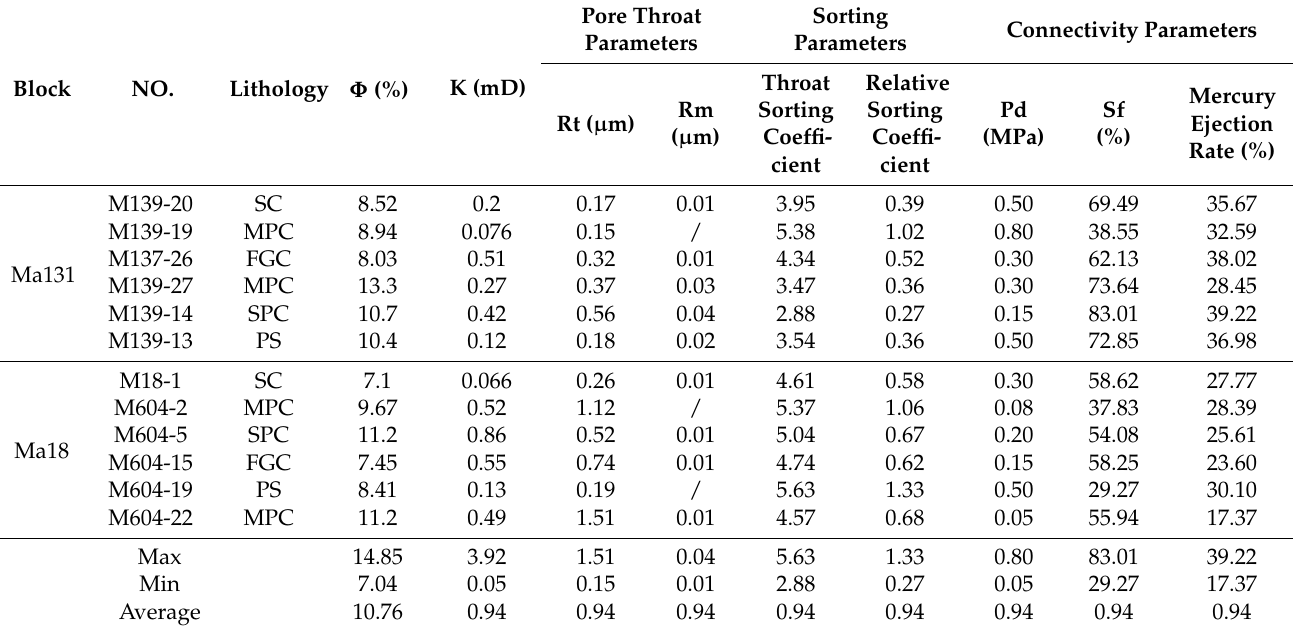
Table 3. Pore-throat parameters from the high-pressure mercury injection experiments on the samples from the Mahu area.